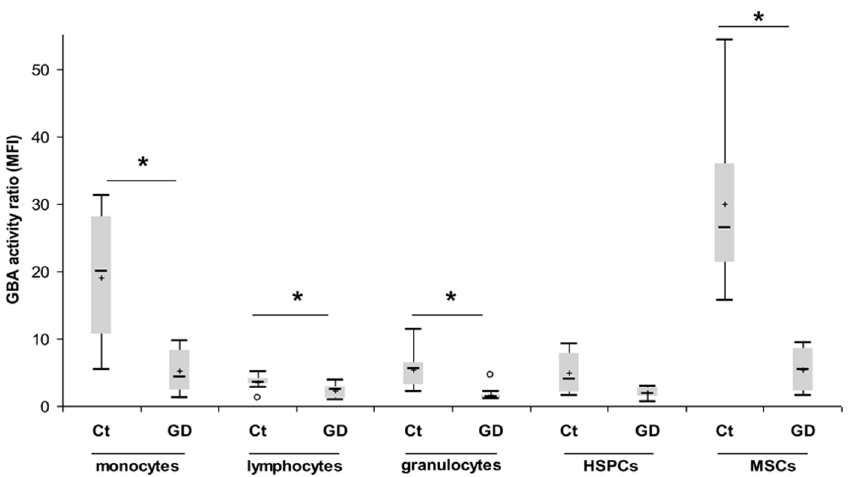
Figure 1. GBA activity measurement in blood and BM cells. GBA activity was measured in blood and BM cell subtypes of GD patients (GD) and healthy donors (Ct). Results are expressed as an index defined by the ratio between median fluorescence intensity (MFI) of cells incubated with PFB- FDGlu alone and MFI of cells incubated with CBE and PFB-FDGlu (blood: n=10 for GD and controls; BM: n=8 for GD and 6 for controls).